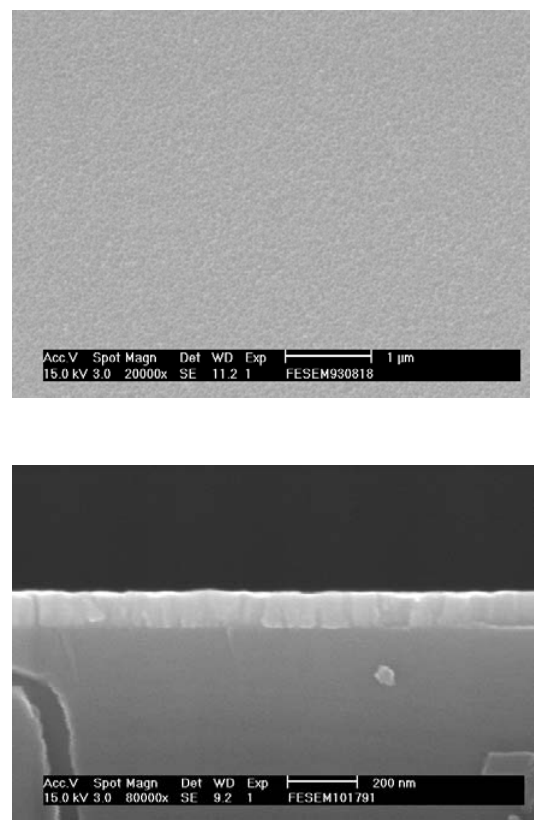
Figure 3. SEM surface and cross-section morphologies for ZnO:Al film deposited at RF power of 120